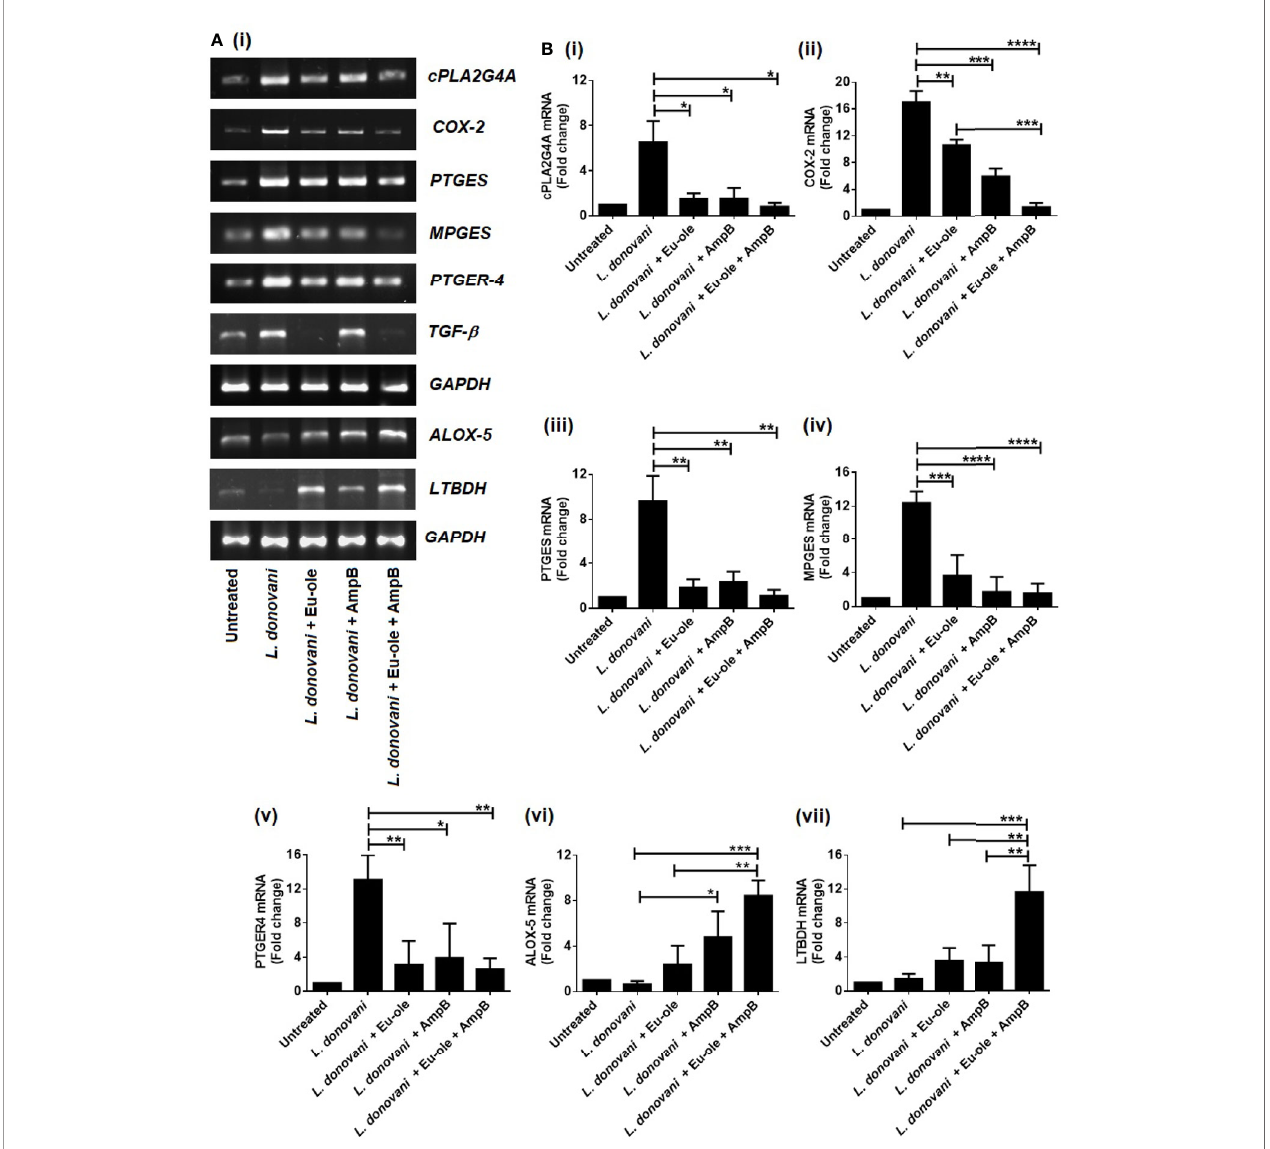
FIGURE 2 | Biphasic expression in arachidonic acid enzymes pro fi le during combinatorial treatment. Macrophages were infected with L. donovani (1:10 ratio). After 24 hr of post infection treatment was given in monotherapy as well as in combination therapy to infected macrophages. After 6 hr, cells were collected in Trizol to determine the mRNA expression of arachidonic acid enzymes were analysed by RT PCR (A) and the transcription levels of AA genes cPLA2g4A, COX-2, PTGES, MPGES, PTGER4, TGF- b , and ALOX-5, LTBDH were analysed by quantitative real time PCR ( B i-vii). The results were expressed as mean ± SD. *p < 0.05, **p < 0.01, ***p < 0.001, signi fi cant differences between the indicated